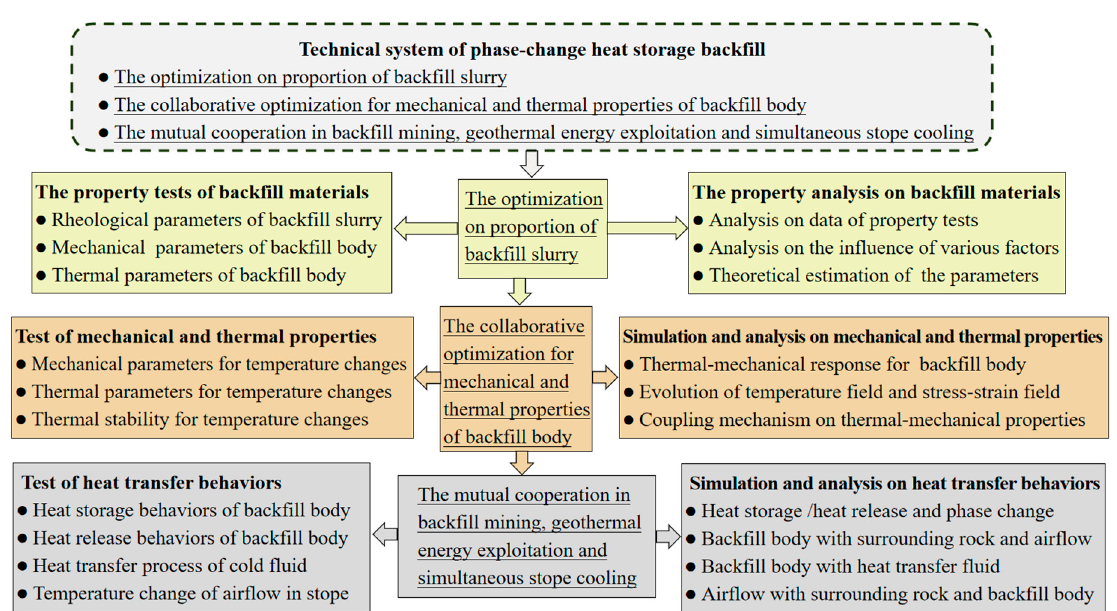
Figure 3. The technical system for phase-change heat storage backfill.